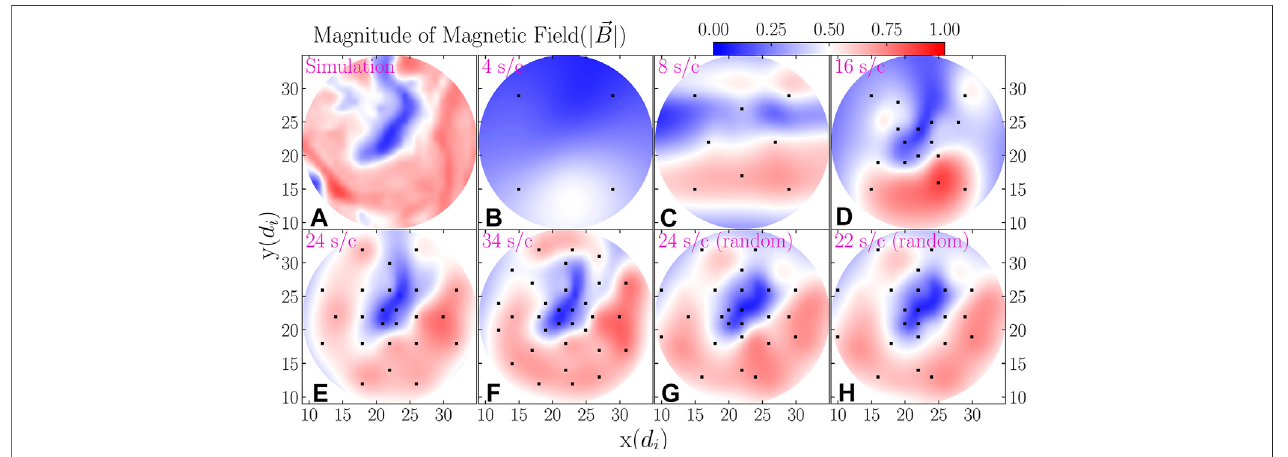
FIGURE A3 | Same as Figure 4 , but for B ≡ | B | , the magnitude of the magnetic fi eld.